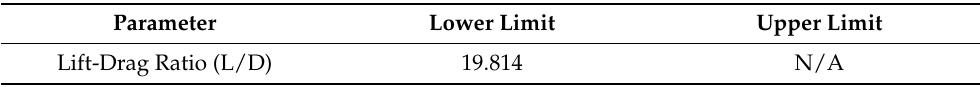
Table 5. Optimization constraint condition settings.